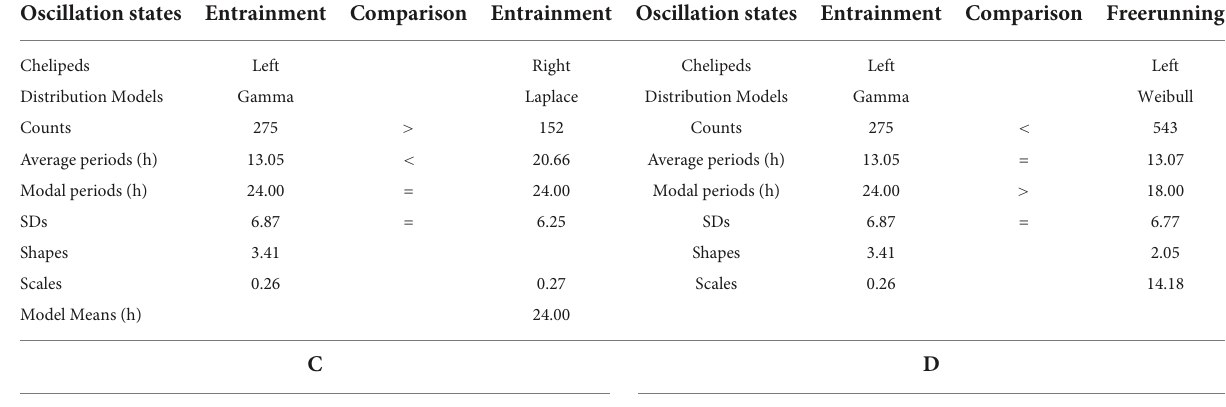
TABLE 1 Models and parameters of the records presented in Figure 1 . A